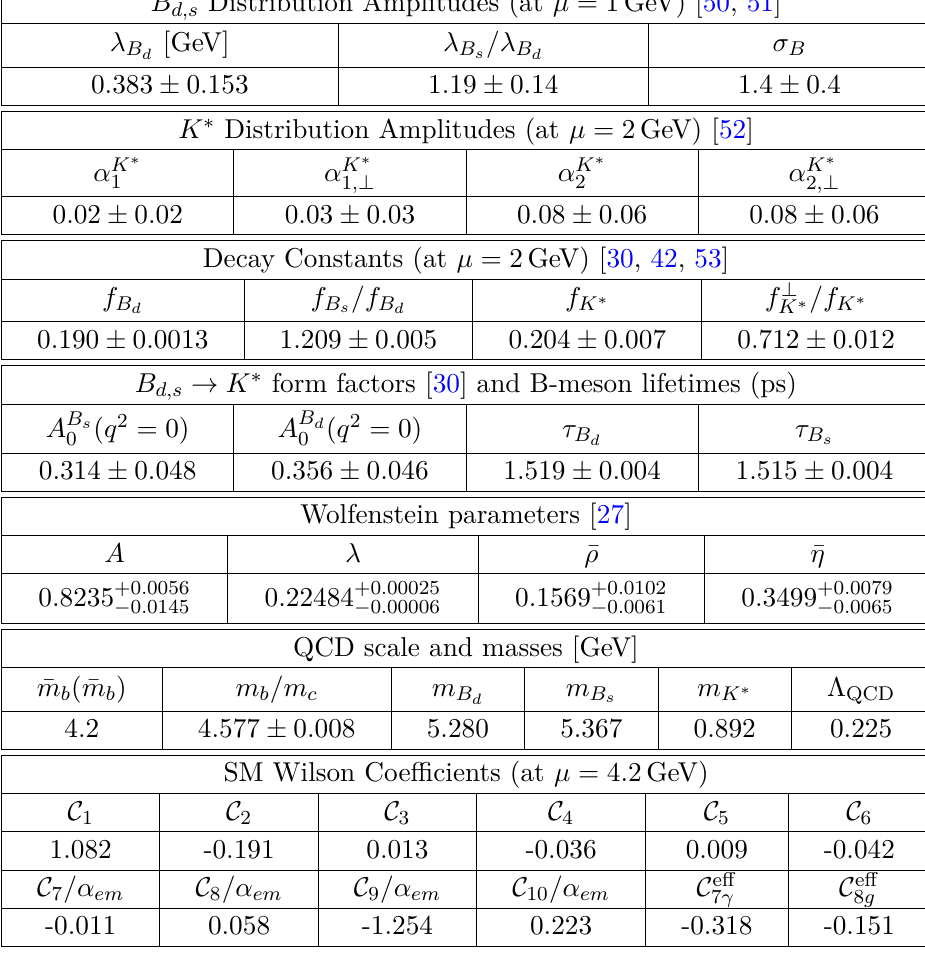
Table 3 . Input parameters used to determine the SM